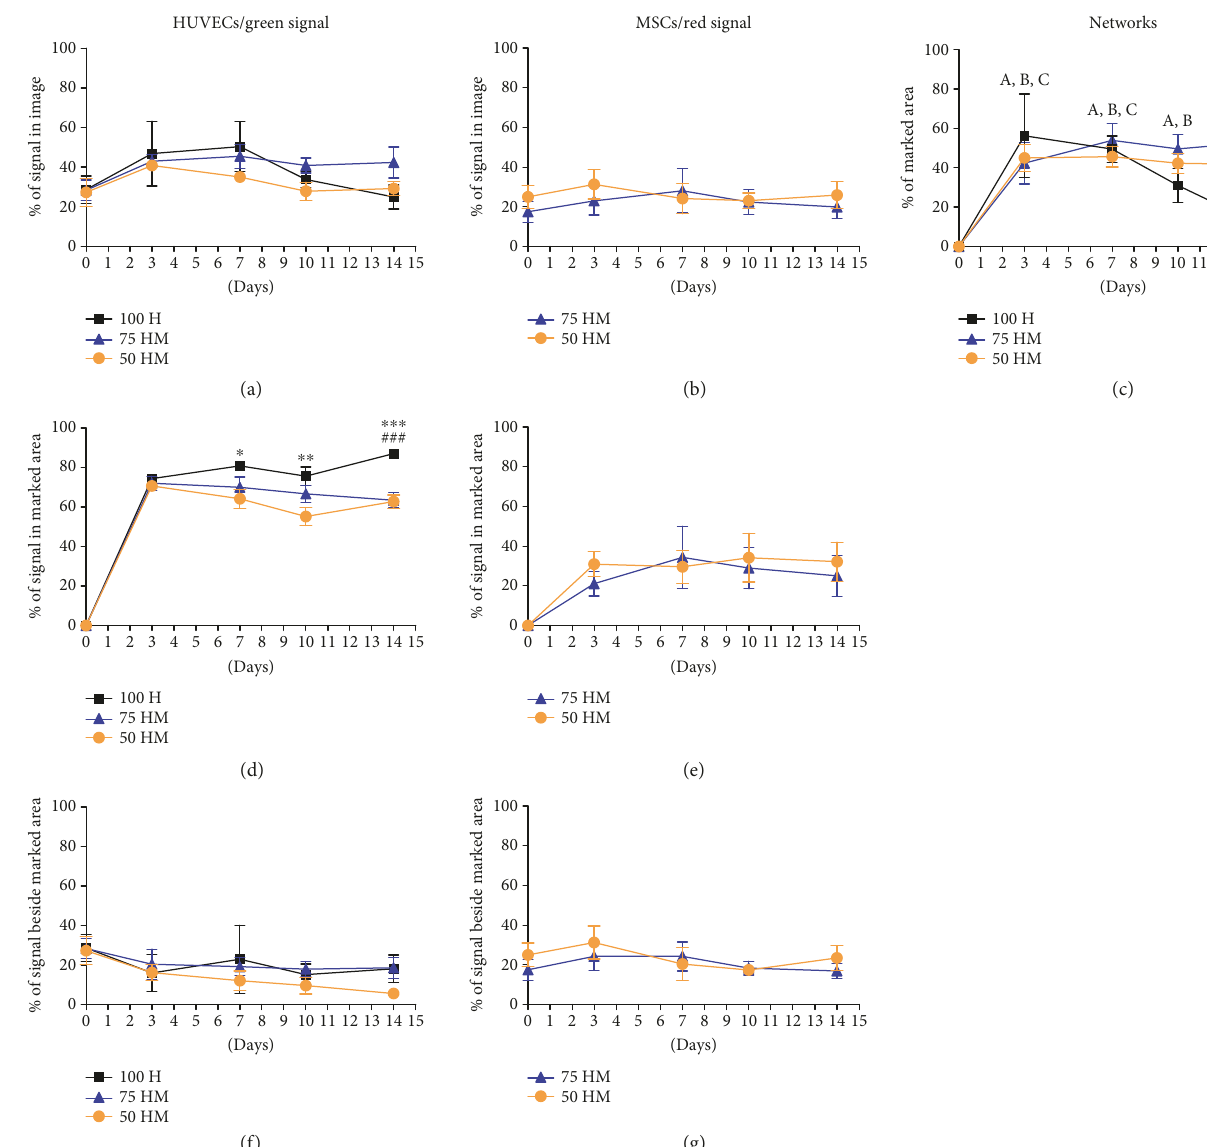
Figure 5: Analysis of cellular networks. Image analysis was performed of mono- and cocultures (100% HUVECs (100H), 75% HUVECs – 25% MSCs (75 HM), and 50% HUVECs – 50% MSCs (50 HM)) in PRP (seeding density: 2.5 × 10 3 cells/ μ l gel) ( n = 3 ). Networks were measured by manually marking cellular networks. The relative percentage of prestained green (HUVECs) and red (MSCs) cells was investigated for day 0, day 3, day 7, day 10, and day 14 in the following regions: relative percentage of green or red signal in the entire image (a, b), relative percentage of marked network area (c), relative percentage of green or red signal in marked network area (d, e), and the relative percentage of green or red signal beside marked network area (f, g). For 100 H monocultures, networks decreased after one week whereas in both cocultures, networks were present and stable after two weeks (c). Cellular networks were mainly made out of HUVECs (d), with a minor contribution of MSCs (e). Two-way ANOVA with Tukey ’ s post hoc test for multiple comparison was applied to test for signi fi cant di ff erences over time (compared to day 0: (A) 50HM p < 0 01 (all time points); (B) 75HM p < 0 01 (day 3) and p < 0 001 (day 7 – 14); and (C) 100H p < 0 001 (day 3) and p < 0 01 (day 7)) and between di ff erent culture conditions ( ∗ p < 0 05 , ∗∗ p < 0 01 , ∗∗∗ p < 0 001 compared to 50HM, ### p < 0 001 compared to 75HM). n = 3